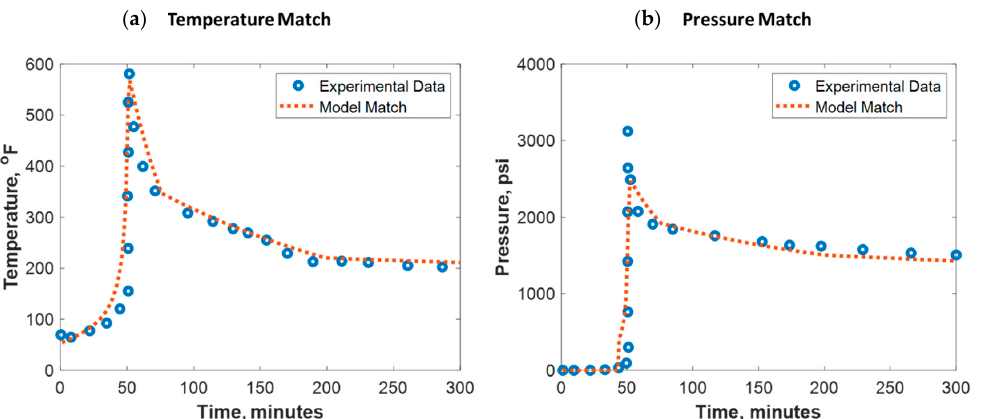
Figure 7. ( a ) Temperature and ( b ) pressure match against experimental data conducted in an autoclave reactor.